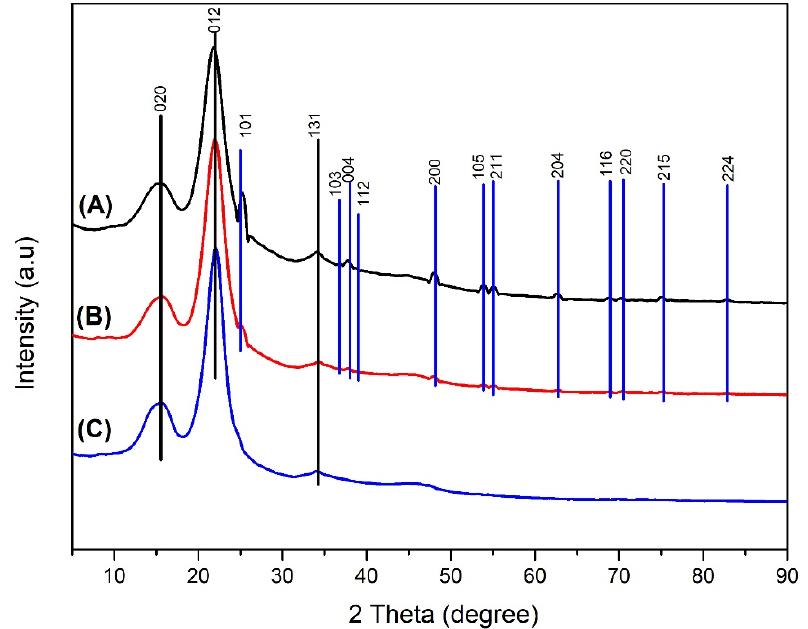
Figure 13. Diffractogram ( A ) impregnated mangium wood with 5% TiO 2 nanoparticle ( B ) impregnated mangium wood with 1% TiO 2 nanoparticle ( C ) untreated mangium wood. The XRD analysis indicated that mangium wood impregnated with 1% TiO 2